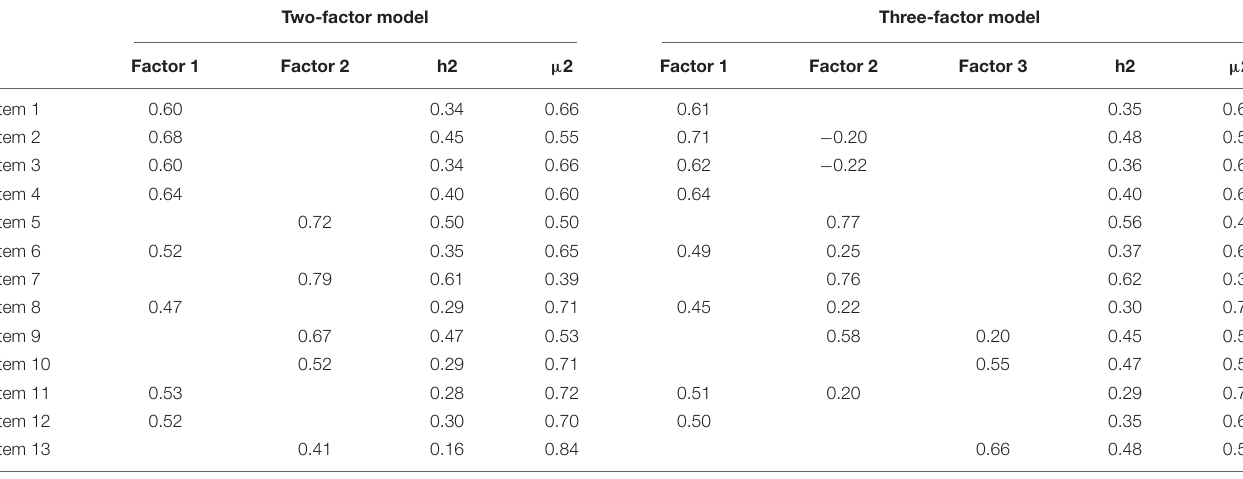
TABLE 4 | Results of the EFAs for the two- and three-factorial solutions ( n = 2,407).